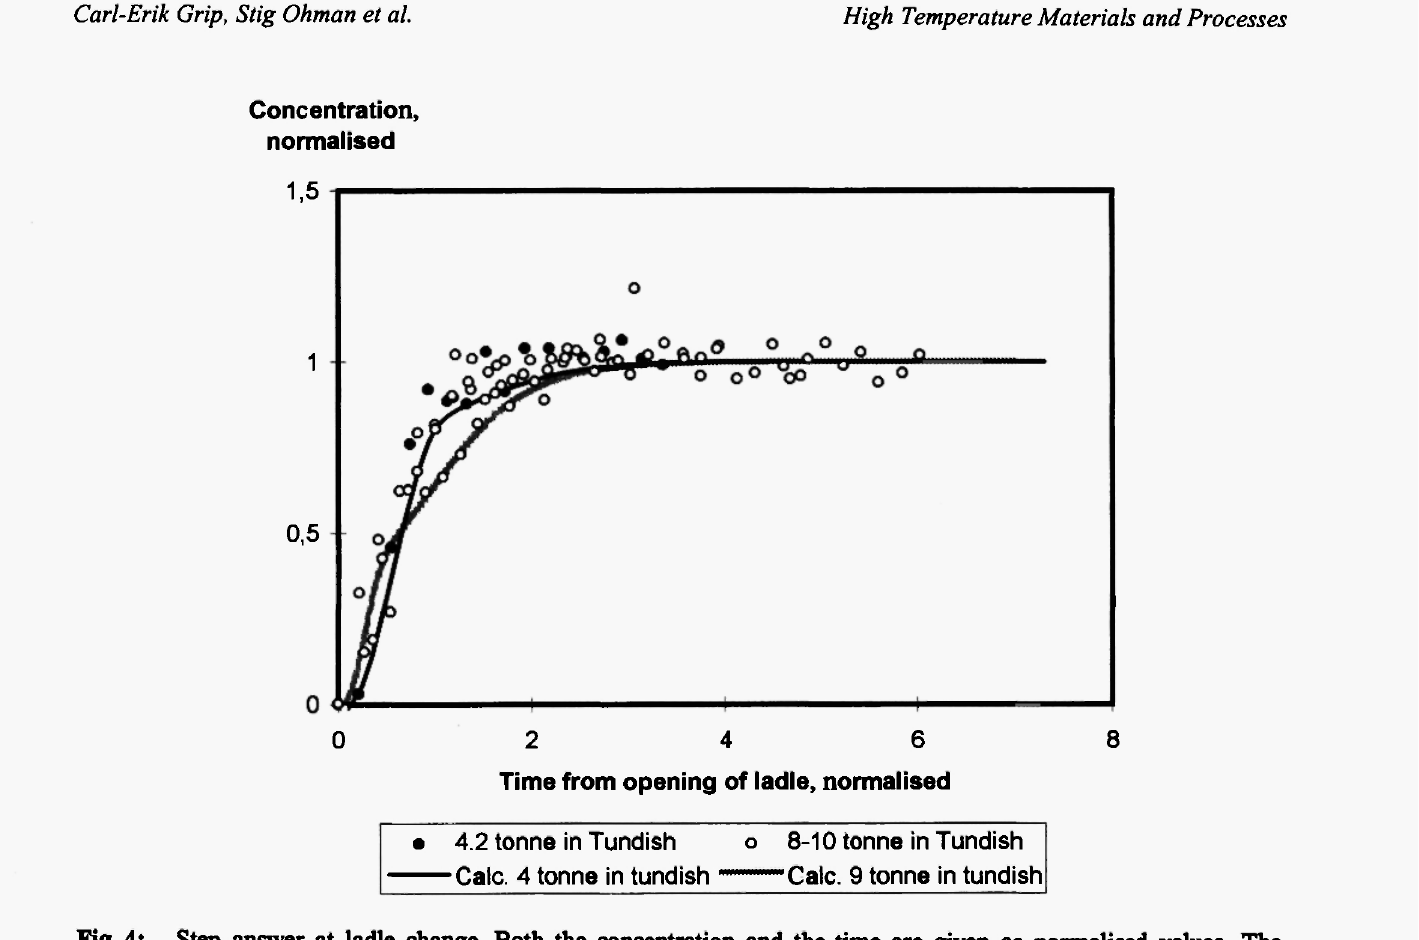
Step answer at ladle change. Both the concentration and the time are given as normalised values. The definitions are given in the text Data are included from four heats. The steel weight in the tundish at start was 4.2 tonnes on one heat and ranged from 8 to 10 tonnes in the other three. Calculated concentration curves for cases with 4 and 9 tonnes in the tundish at start have been included in the diagram. Both simulations were made with 4 tanks. A shortcut type C was used during the filling of the tundish. Immediately after the filling of the tundish the flow was assumed to change into steady state flow, i.e., a shortcut type A. The shortcut models, type A and C, are defined in Table